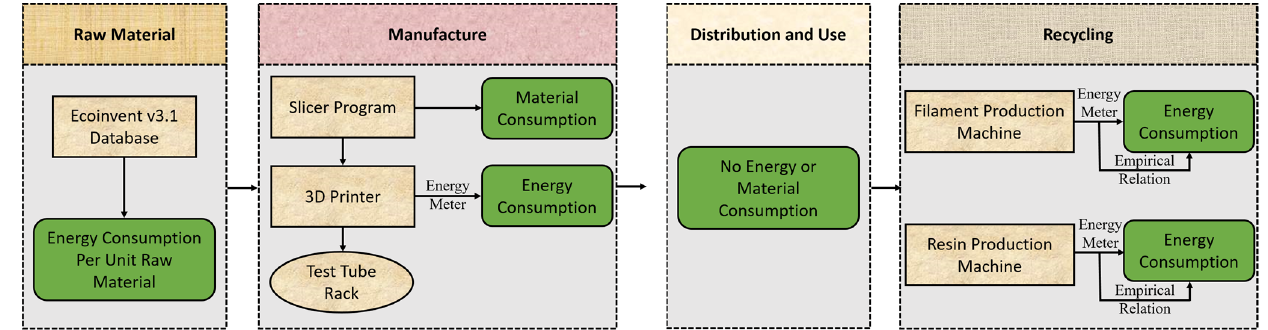
Figure 4. Flow chart showing the life cycle energy analysis model for FDM and SLA additive manufacturing methods.